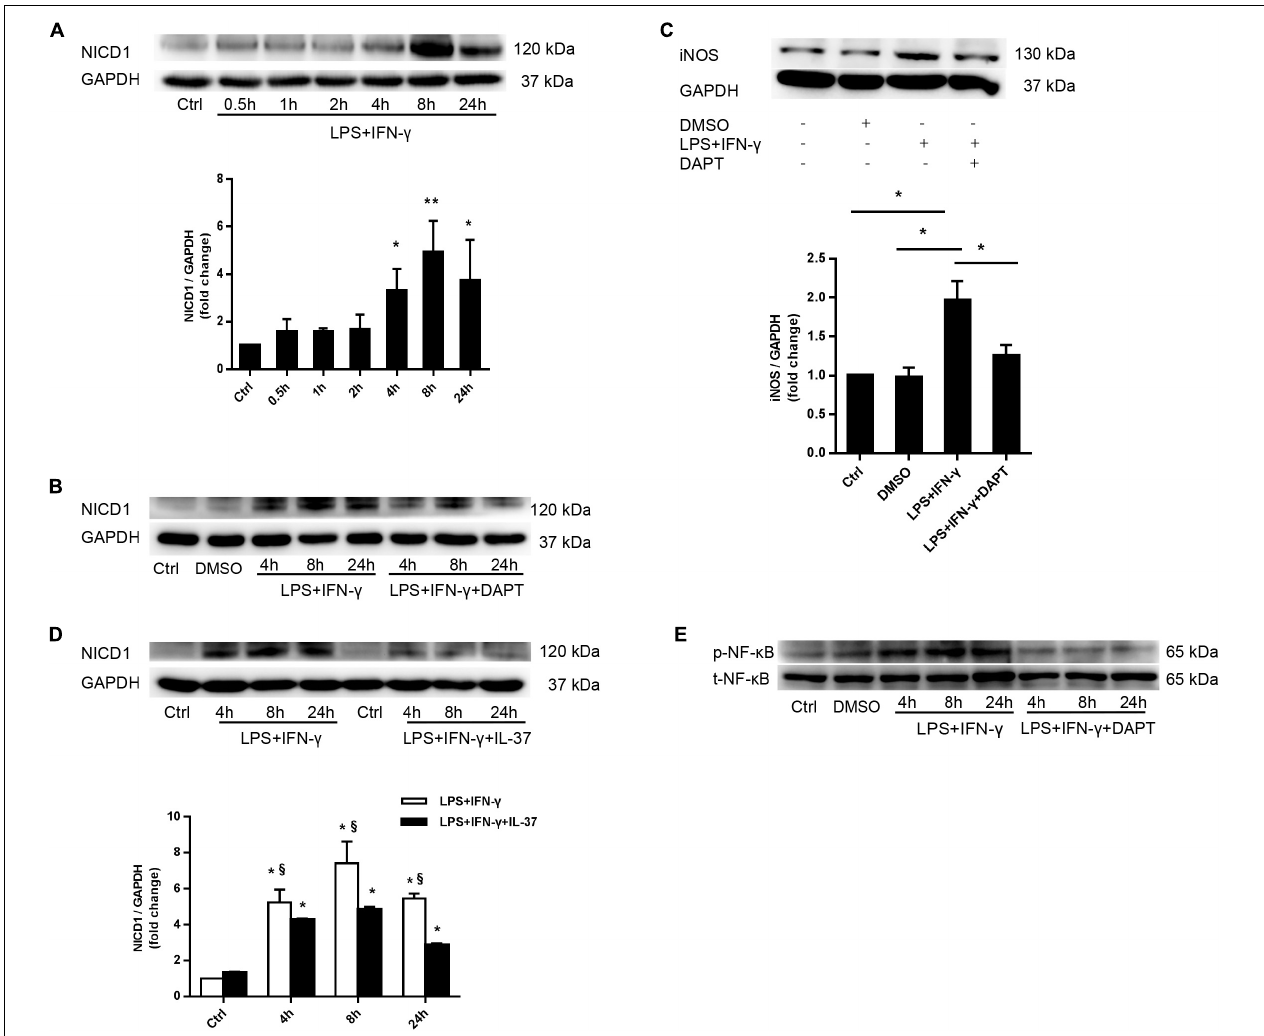
FIGURE 5 | IL-37 modulates macrophage polarization through suppressing activation of the Notch1- NF- κ B pathway axis. (A) Representative immunoblots and densitometric data show that stimulation with LPS and IFN- γ enhances Notch1 pathway activation in PMA-treated THP-1 cells; n = 3, * P < 0.05, ** P < 0.01. (B,C) PMA-treated THP-1 cells were treated with DAPT (50 µ M) 1 h prior to LPS (100 ng/ml) and IFN- γ (20 ng/ml) for 4–24 h. (B) Representative immunoblots show that DAPT inhibits Notch1 activation; n = 3. (C) Representative immunoblots and densitometric data show that Notch1 pathway inhibition reduces iNOS expression in M1 macrophages; n = 3, * P < 0.05. (D) PMA-treated THP-1 cells were treated with recombinant human IL-37 (0.1 ng/ml) 1 h prior to being treated with LPS (100 ng/ml) and IFN- γ (20 ng/ml) at different times. Representative immunoblots and densitometric data show that IL-37 decreases NICD1 expression at different time point in M1 macrophages; n = 3. * P < 0.05 vs. corresponding control, § P < 0.05 vs. M1 macrophages treated with IL-37. (E) Representative immunoblots show that Notch1 pathway inhibition decreases NF- κ B phosphorylation; n =